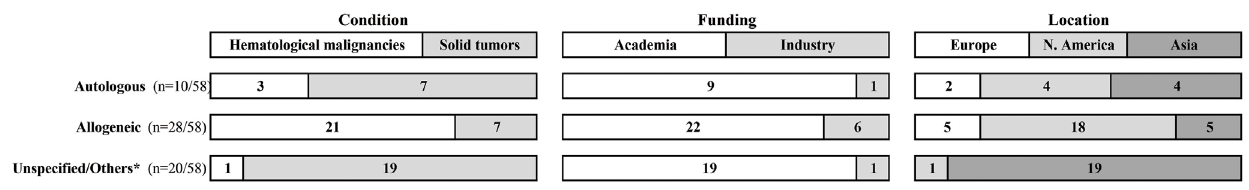
FiGURe 1 | Ongoing clinical trials that evaluate nK cell-based cellular therapies . Data were collected at https://clinicaltrials.gov/ in September 2016, using the search terms: “recruiting studies,” “NK,” or “natural killer” in the “Title” field. Raw data are available in Data Sheet S1 in Supplementary Material. *Unspecified = 18 studies with no designation whether NK cells are autologous or allogeneic; others = 1 study tests NK cell line and 1 study compares autologous to allogeneic NK